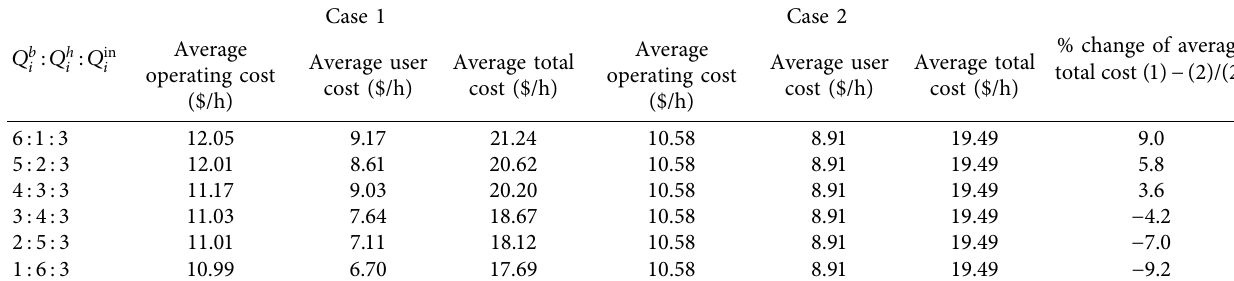
Table 7: Effects of ratio of demands on